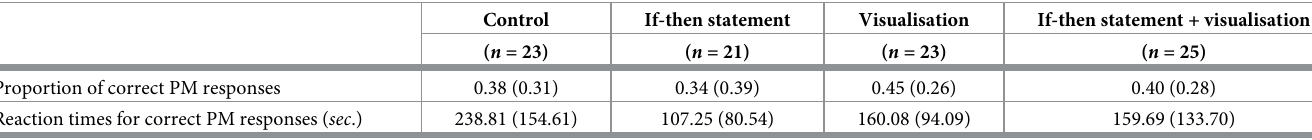
Table 3. PM performance as a function of